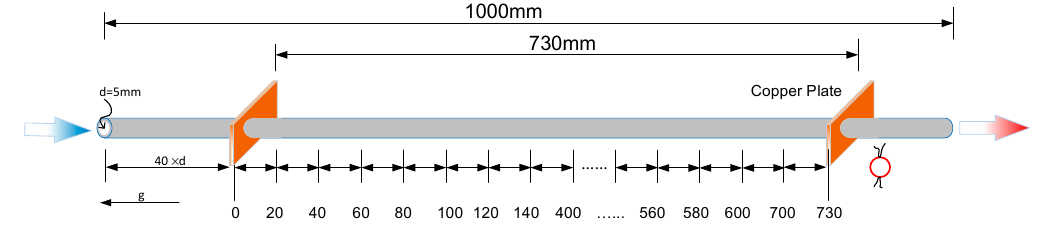
Figure 5. Installation of the thermocouples at the outer wall of the test section.